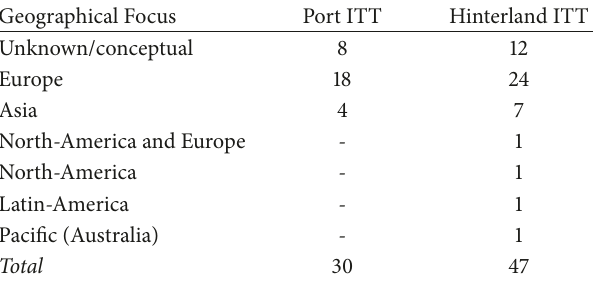
Table 2: The geographical focus of reviewed